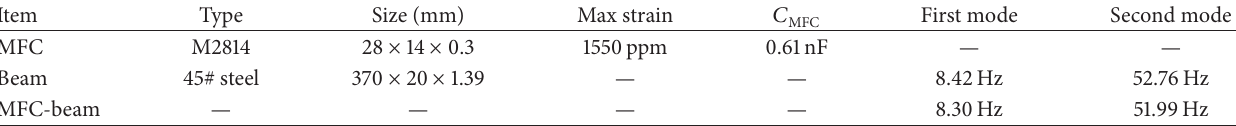
Table 1: Parameters of MFC and vibrating